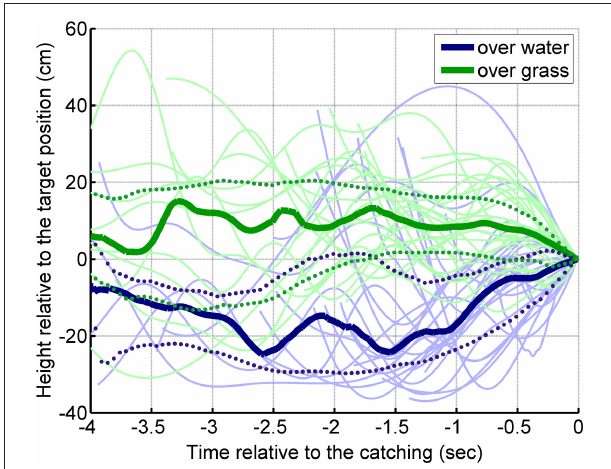
FIGURE 4 | Flight height of the bats in the last 4s before making a capture at a target height of 35cm. The moment of the capture is shown at 0s (on the right side of the graph). On average, the bats flew around 10cm above the target height when they were presented above grass (thick green line). When the targets were presented above water, the bats flew about 10–20cm below the target height (thick blue line). The strong continuous lines show the median of the flight paths, the dotted lines show the upper and lower quartiles.